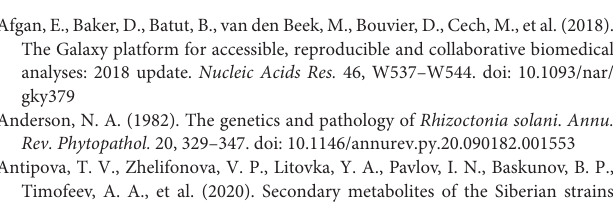
Supplementary Table 3 | Experiment L. Over-representation analysis (false discovery rate or FDR < 0.05) of the gene ontology (GO) terms associated with the differentially expressed genes (DEGs) identified in the RNA-Seq experiment. Supplementary Experiment 1 | Magnitude of CHA0’s effect against H. abietinum